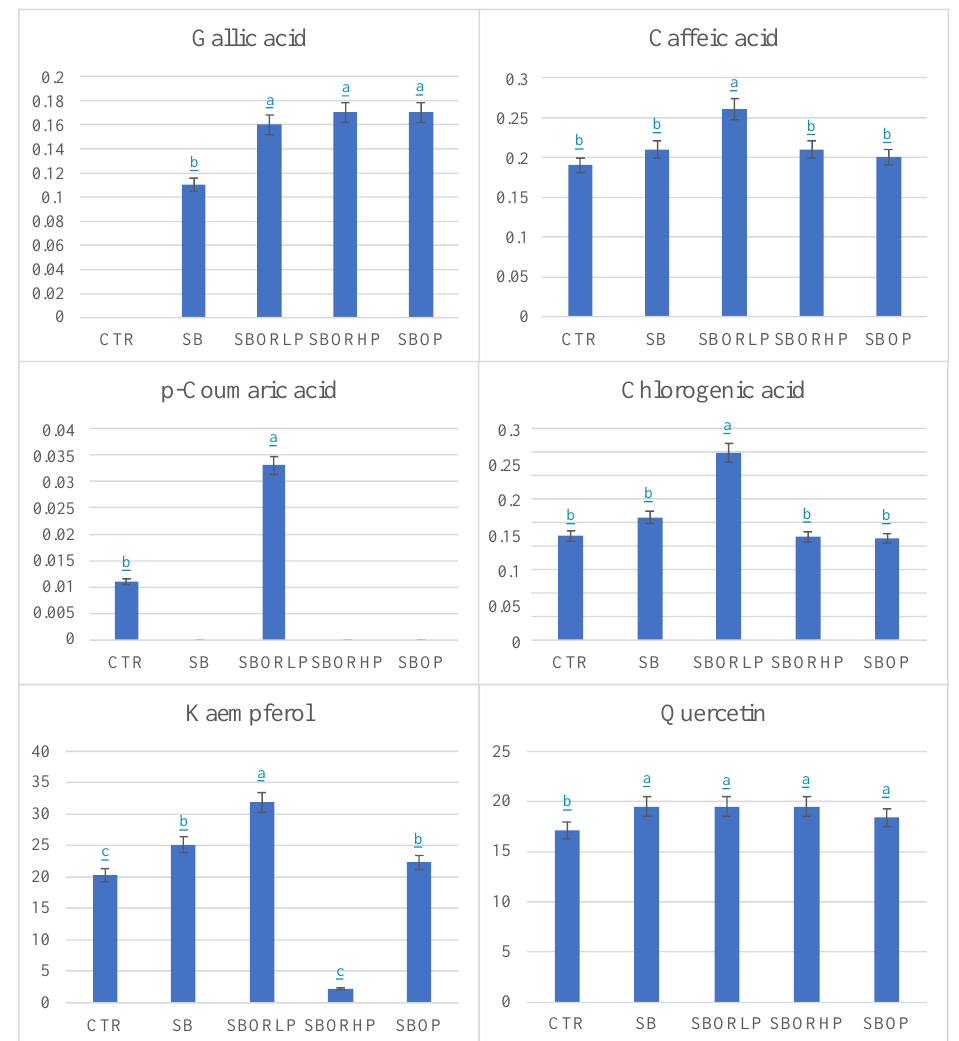
Figure 1. Phenolic acids and flavonols (mg · 100 · g − 1 FW) found in red onion bulbs differently fertilized: control (CTR), sulphur bentonite (SB), sulphur bentonite-low percentage orange residue (SBOR LP), sulphur bentonite-high percentage orange residue (SBOR HP), and sulphur bentonite—olive pomace (SBOP). Data are the mean of three replicates ± the standard error. Different letters indicate significant differences at p < 0.05.